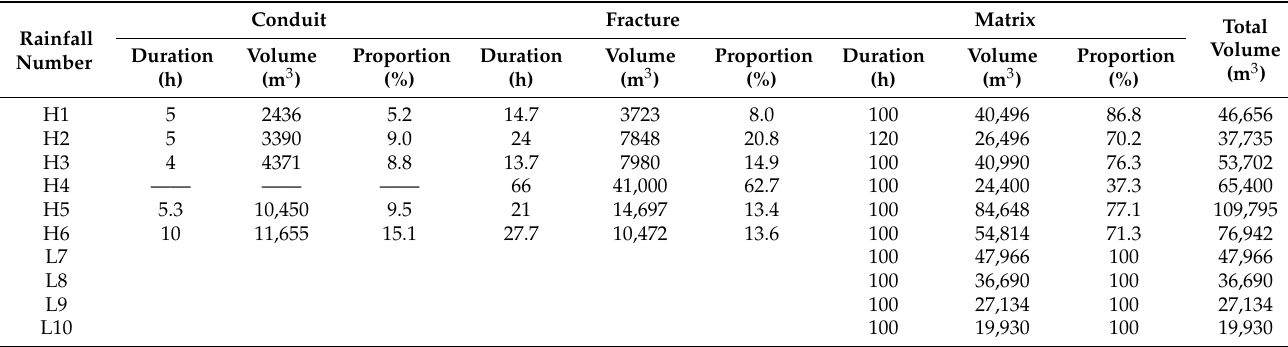
Table 5. Ratio of water release from different media.